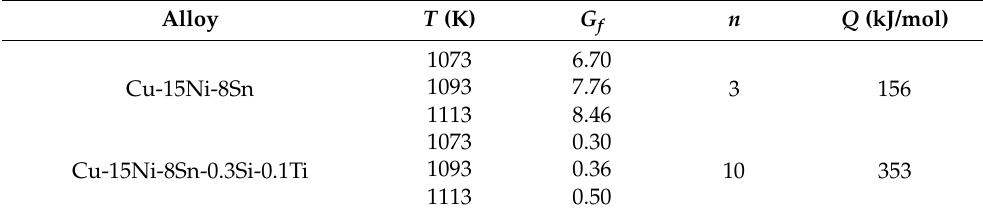
Table 2. Grain growth factor ( G f ), grain grow exponent ( n ), and activation energy ( Q ) for the studied alloys with a solution process of 2